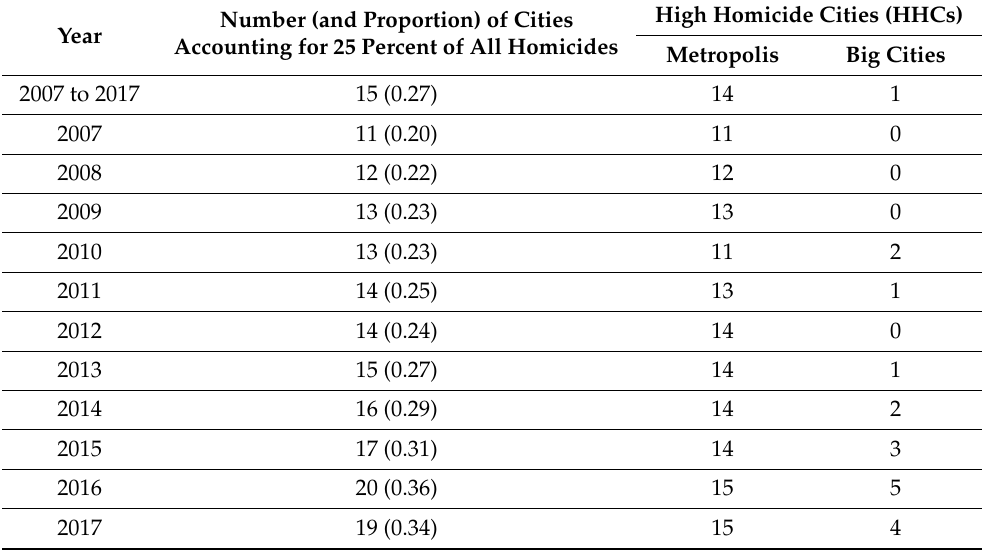
Table 1. The concentration of homicides in Brazil between 2007 and 2017, and the types of cities that were HHCs. Number (and Proportion) of Cities Year Accounting for 25 Percent of All Homicides